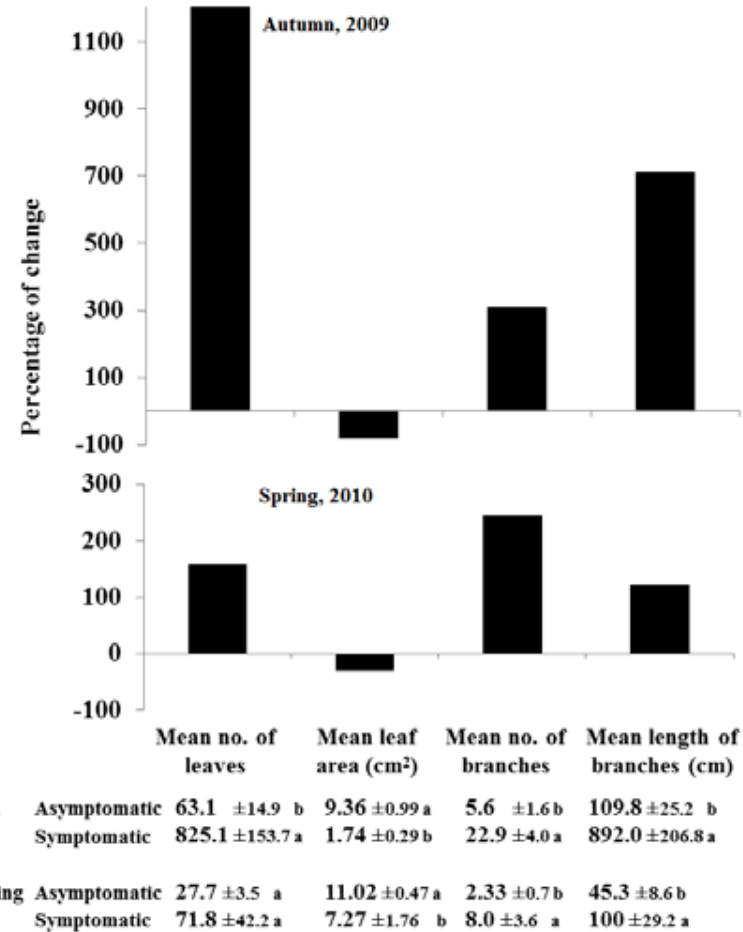
Figure 4. Percentage changes in mean numbers of leaves, leaf areas, numbers of branches and length of branches in symptomatic acid lime branches affected by witches’ broom. Values below the figure indicate mean values and standard errors. Values accompanied by the same letter in the each column and season are not significantly different ( P < 0.05; (Duncan’s Multiple Range